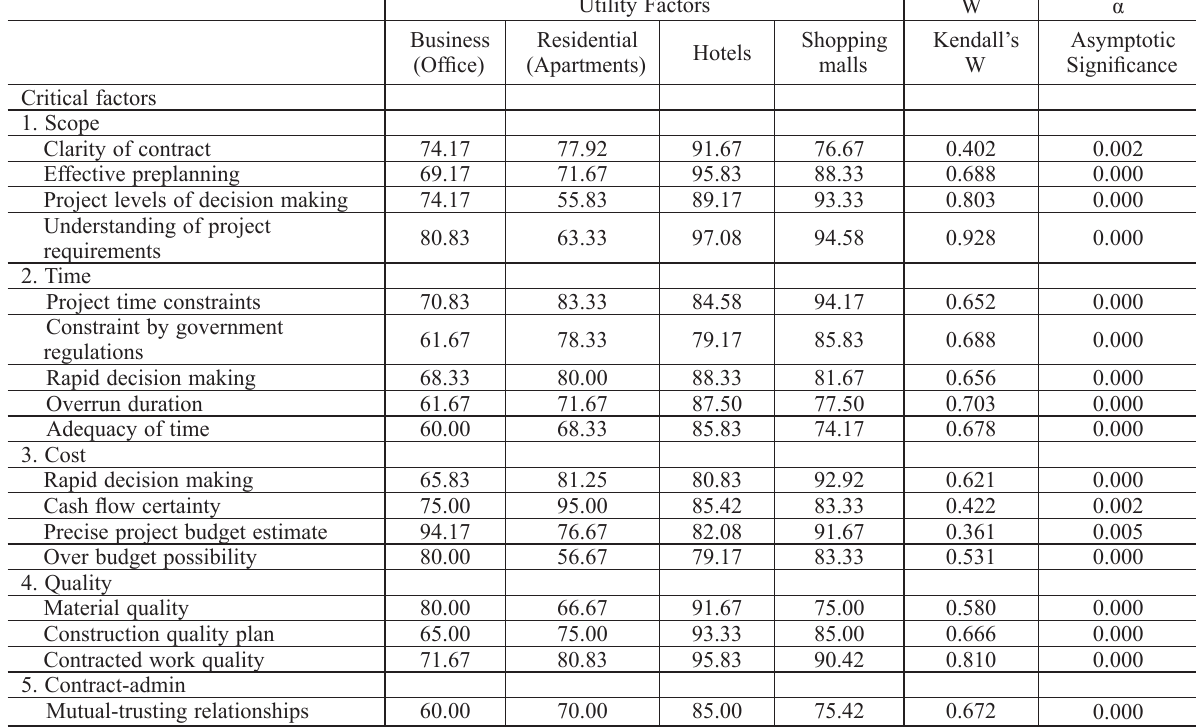
Table A.1. Selection